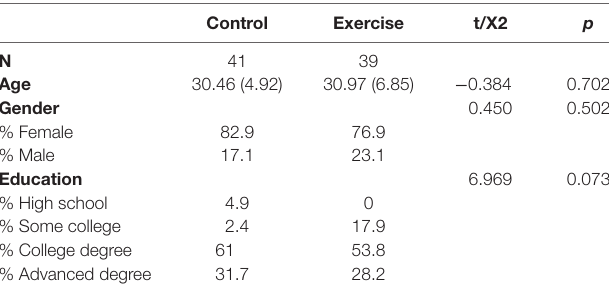
TABLE 1 | Baseline demographic